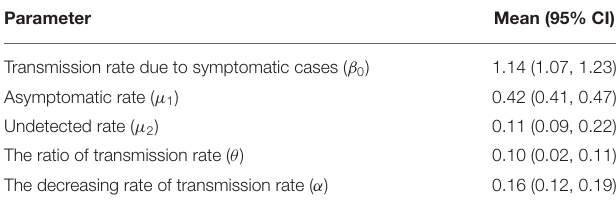
TABLE 2 | Posterior estimates of key epidemiological